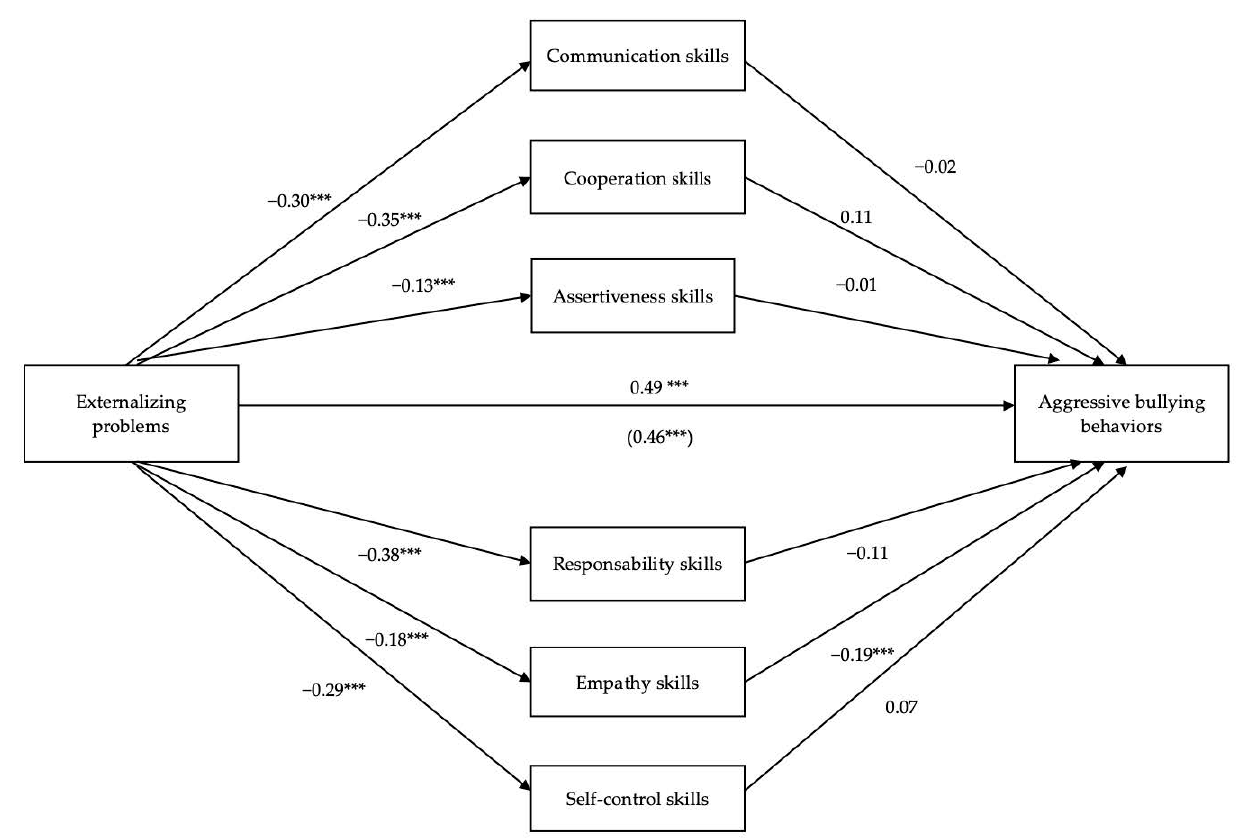
Figure 1. The mediating role of social skills in the relation between externalizing problems and aggressive bullying behaviors (N = 669). *** p <